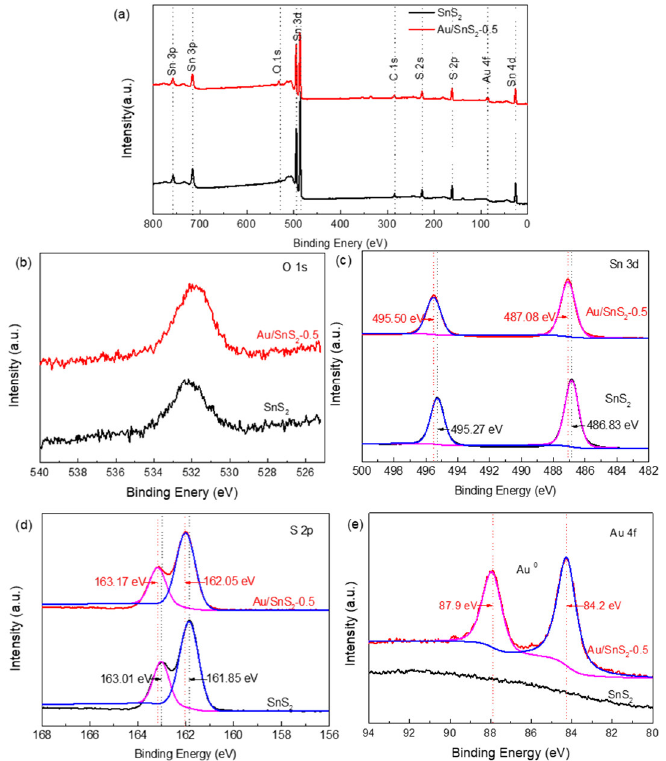
Figure 6. XPS spectra of SnS 2 and Au/SnS 2 -0.5: ( a ) full survey spectra of samples, ( b ) O 1s region, ( c ) Sn 3d region, ( d ) S 2p region, and ( e ) Au 4f region.